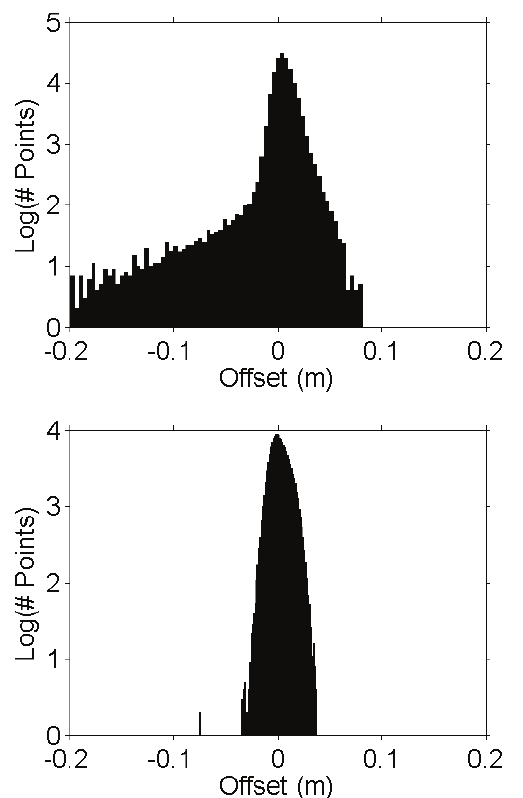
The HRS-3D data shows three distinct range return peaks around 185 m. Two of these are due to the double-layered mesh (a sepa- ration of only a few cm) while the third peak is due to the horizon- tal frame at the bottom of Target 2. The central vertical support at 185.55 m and the backboard at 186.2 m are both clearly defined